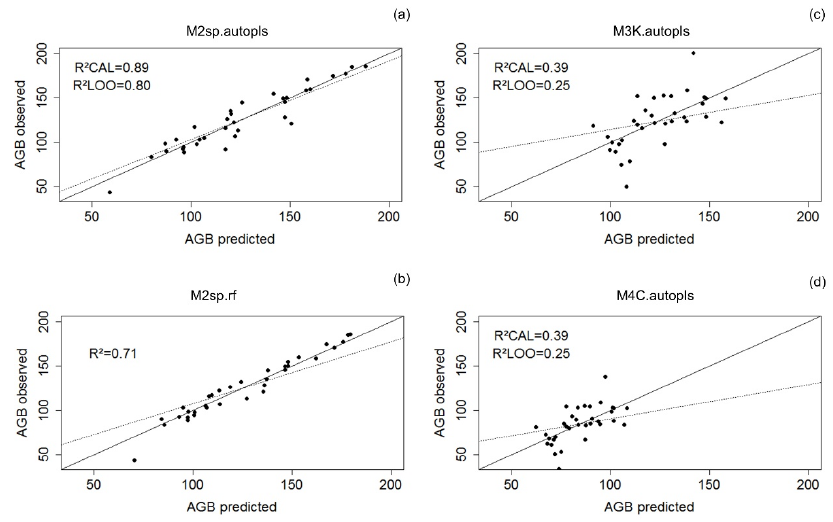
Figure 6. Scatter plots of predicted versus observed AGB (t·ha −1 ) for ( a ) M2sp.autopls model (Auto-PLS); ( b ) M2sp.rf model (RF); ( c ) M3K.autopls and; ( d ) M4C.autopls. R 2 for RF are comparable to R 2 (CAL) for Auto-PLS. R 2 (CAL) is the coefficient of determination in